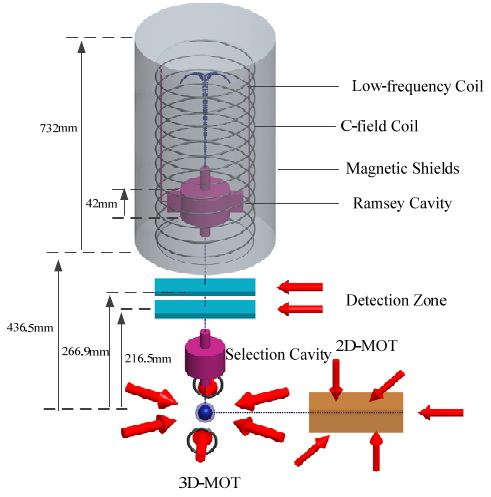
Figure 3. Working process of Cesium atomic fountain clock.